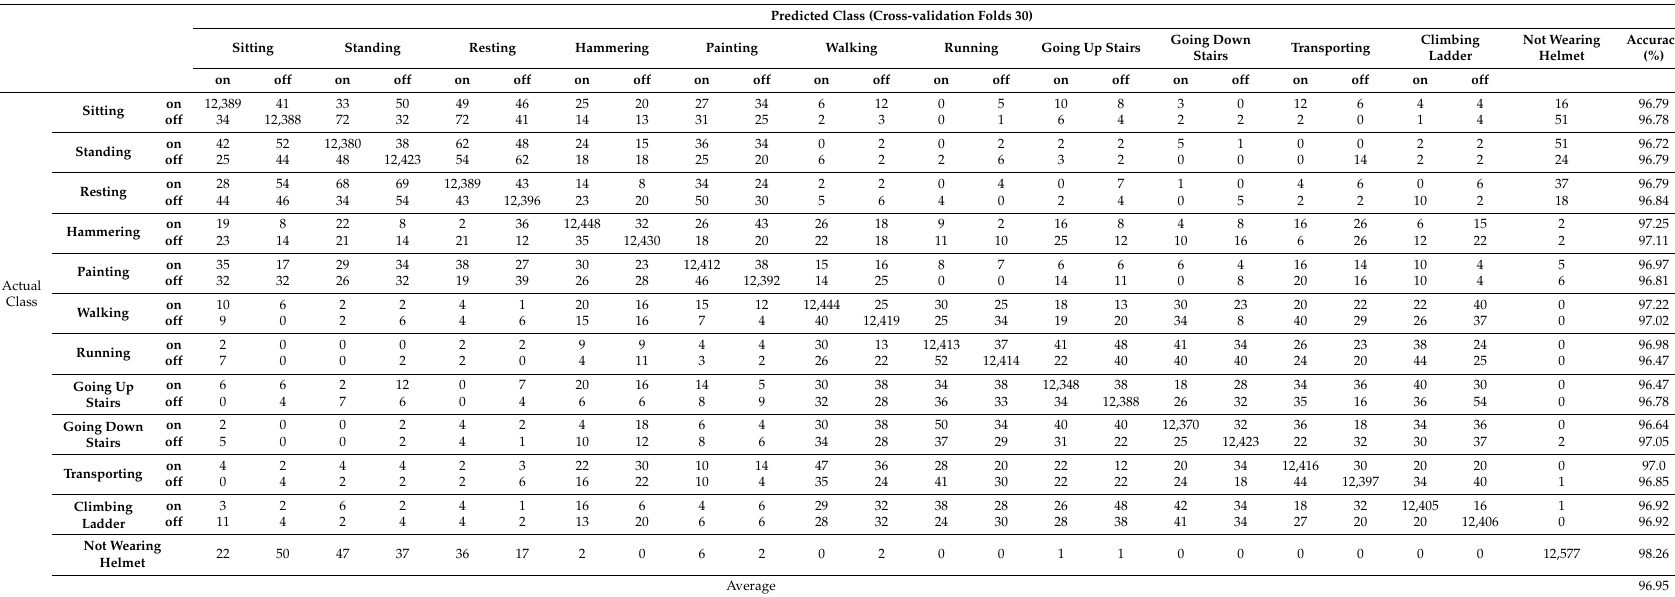
Table 4. Experimental classification results for properly wearing, improperly wearing, and not wearing the safety helmet according to worker